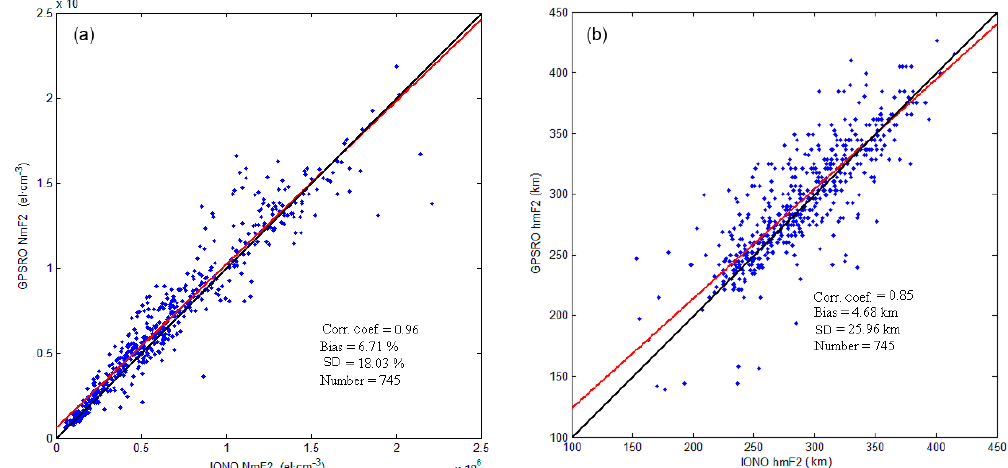
Figure 4. Comparison of NmF2 measurements from GNOS GPS occultation and ionosondes. Panel (a) shows a linear regression of the absolute NmF2 values measured using the two methods. The black line is y = x , the red line is the fitted regression, corr. coef. is the correlation coefficient, bias is the statistical bias, and SD is the standard deviation. Panel (b) shows a linear regression of the absolute hmF2 values measured using the two methods (source: Yang et al., 2018).